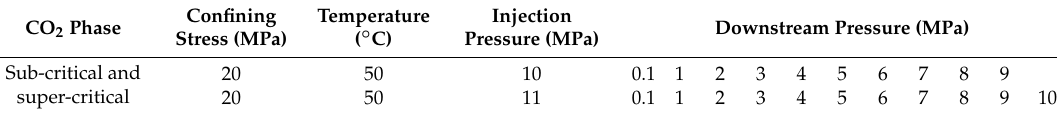
Table 4. Procedure of mixed-phase CO 2 permeability test.